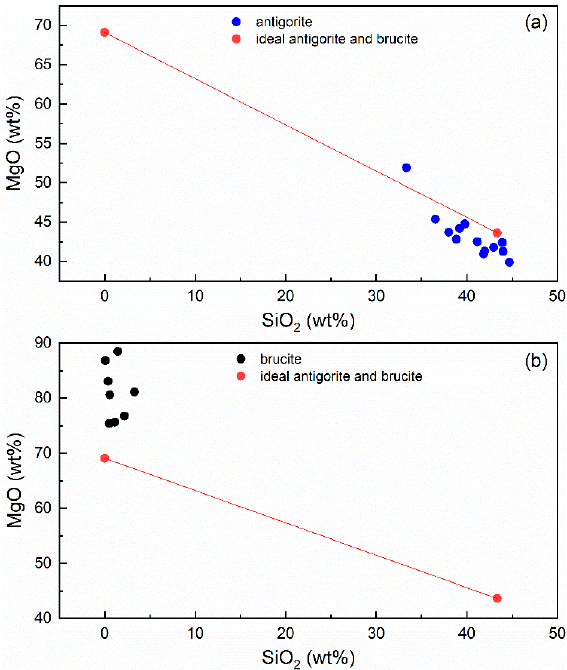
Figure 10. SiO 2 versus MgO of the serpentine (antigorite; a ) and brucite ( b ) in jianite. Some electron microprobe (EMP) analyses of the antigorite may include small amounts of material from the brucite underneath, leading to a relatively larger composition scattering (Table 3). The EMP analyses of the brucite may have suffered a beam-focusing problem, leading to much higher totals (the total of the anhydrous components should be close to ~69.1%).